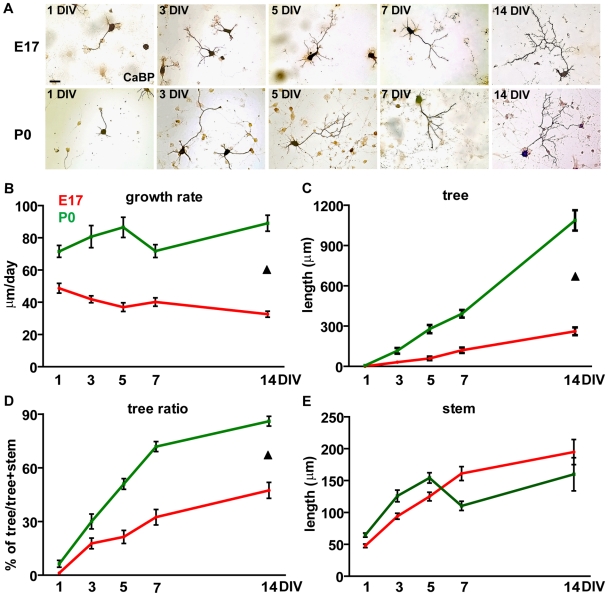
Temporal evolution of axon growth in Purkinje cells plated at different developmental stages.(A) Representative images of calbindin-labeled (CaBP) PC axons at 1, 3, 5, 7 and 14 days in vitro (DIV) in embryonic (E17) and postnatal (P0) cultures. Scale bar, 50 µm. (B) Morphometric analysis of E17 and P0 PC axons shows that during the two weeks in vitro P0 PCs display a growth rate significantly higher compared to embryonic cells (two way ANOVA, main effect of population, F1,668 = 164.22 P<0.001). (C, D) Tree lengths and tree ratios progressively increase in both E17 and P0 PCs, but the P0 values remain constantly higher than those of the embryonic population (two way ANOVA; tree, main effect of population, F1,668 = 268.26 P<0.001; tree ratio, main effect of population, F1,668 = 110.25 P<0.001). (E) On the contrary, no differences are detected at the statistical level between the two PC populations as far as stem extension (two way ANOVA, P = 0.49). Error bars, SEM. Black triangle: significant main effect of population.